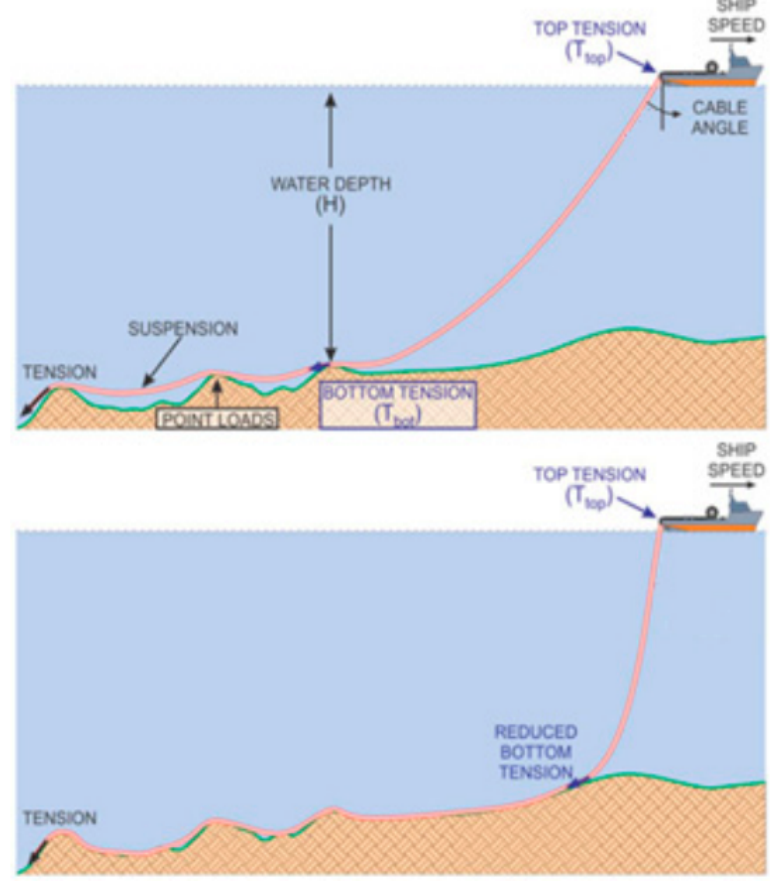
Figure 1. An example of the steep and sloppy topography at the bottom sea